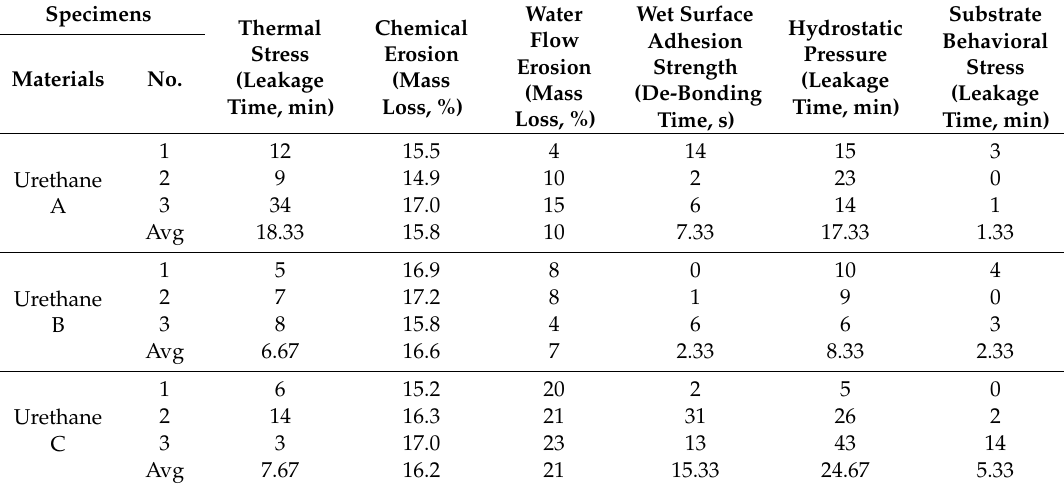
Table 8. The evaluation results of the polyurethane-foam grout-injection material.